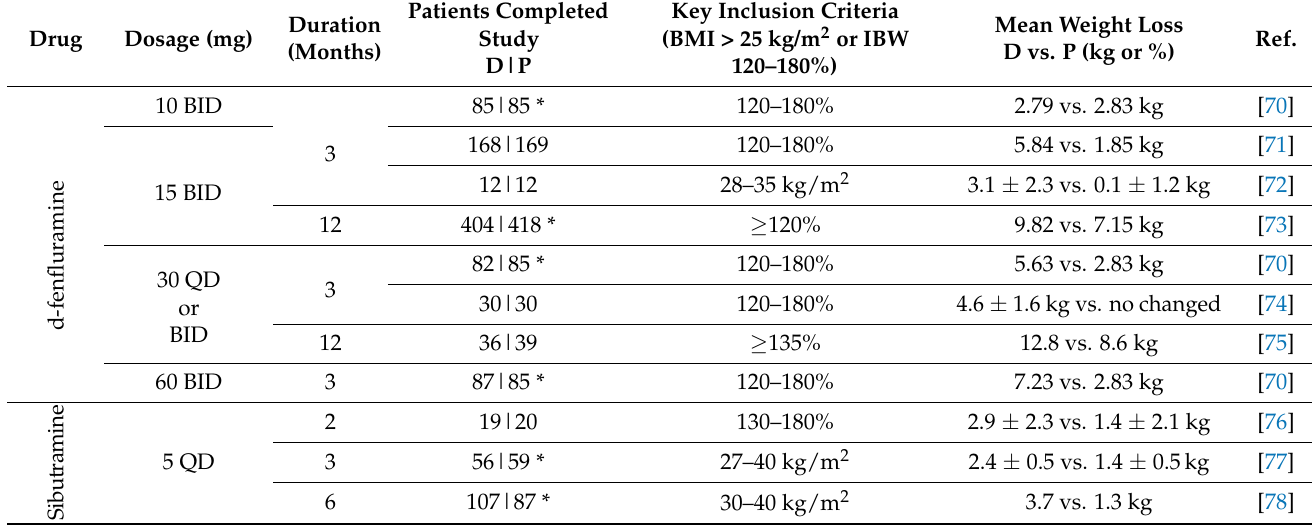
Table 2. Efficacy of 5-HT 2C receptor agonist properties in double-blind, placebo-controlled, ran- domized clinical obesity trials. The patient’s inclusion criteria are increased body mass index (BMI; >25 kg/m 2 ) or ideal body weight (IBW; 120–180%). The mean weight loss (kg or %) of the drug group (D) is compared to the placebo group (P). Multicenter studies were marked by an asterisk